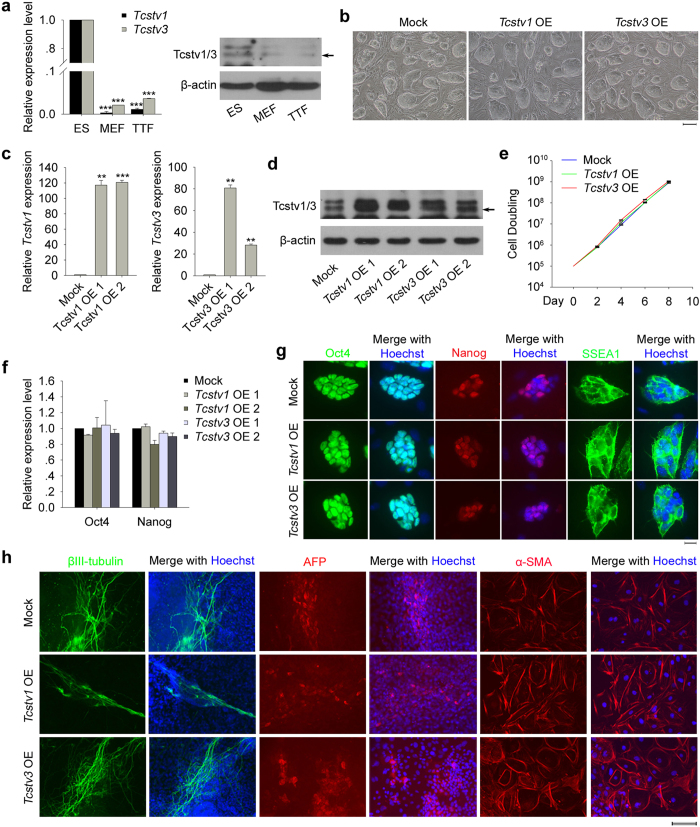
Overexpression of Tcstv1 or Tcstv3 does not affect proliferation, pluripotency and differentiation in vitro of ESCs.(a) Tcstv1 and Tcstv3 expression levels in ESCs, MEFs and TTFs by qPCR (two repeated experiments with duplicated samples each) and western blot. (b) Morphology of stable Tcstv1 overexpression, Tcstv3 overexpression and mock ESCs. Scale bar = 100 μm. (c) Confirmation of overexpression of Tcstv1 and Tcstv3 in respective OE ESCs by qPCR. (d) Western blot experiment confirmed increased expression of Tcstv1 and Tcstv3 protein (pointed by black arrow). (e) Growth curves of Tcstv1 OE, Tcstv3 OE and mock ESCs. 1 × 105 cells were seeded on feeder cells on Day 0 and cells were counted and passaged every two days. (f) Expression levels of Oct4 and Nanog showed no obvious differences among Tcstv1 OE, Tcstv3 OE and mock ESCs by qPCR analysis. (g) Ectopic expression of Tcstv1 or Tcstv3 did not change expression of pluripotency-associated genes by fluorescence microscopy. Scale bar = 20 μm. (h) Overexpression of Tcstv1 or Tcstv3 did not affect differentiation capacity in vitro of ESCs by immunofluorescence staining of markers for ectoderm (βIII-tubulin), endoderm (AFP) and mesoderm (α-SMA). Scale bar = 100 μm. **P < 0.01, ***P < 0.001, compared to controls.